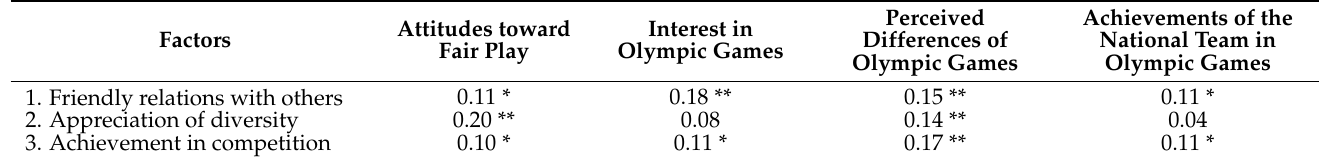
Table 5. Correlation of the values related with Olympic Games with other variables. Interest in Attitudes toward Factors Olympic Games Fair Play